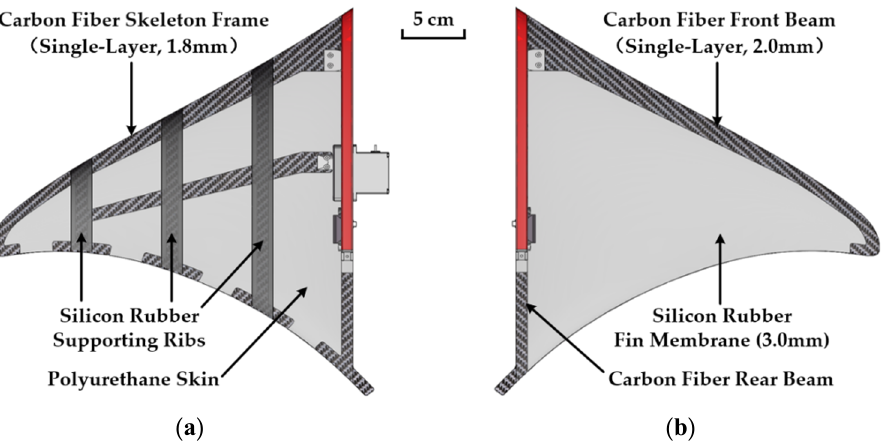
Figure 5. The pectoral fin modules with traditional design. ( a ) Structure of the Type-II fin module; ( b ) Structure of the Type-I fin module .